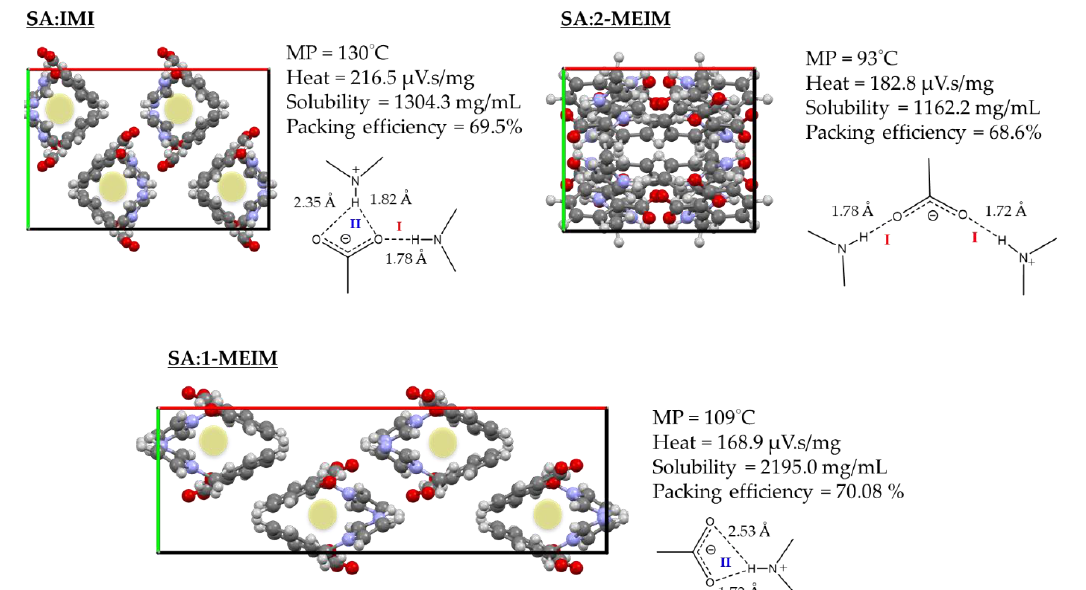
Figure 8. Dissolution rate plot of SA, SA:IMI, SA:1-MEIM and SA:2-MEIM, in both first (1) and second(2) assays, with intensity values of signal at 296 nm (SA absorption band) over relative time (addition of materials at 0 s).